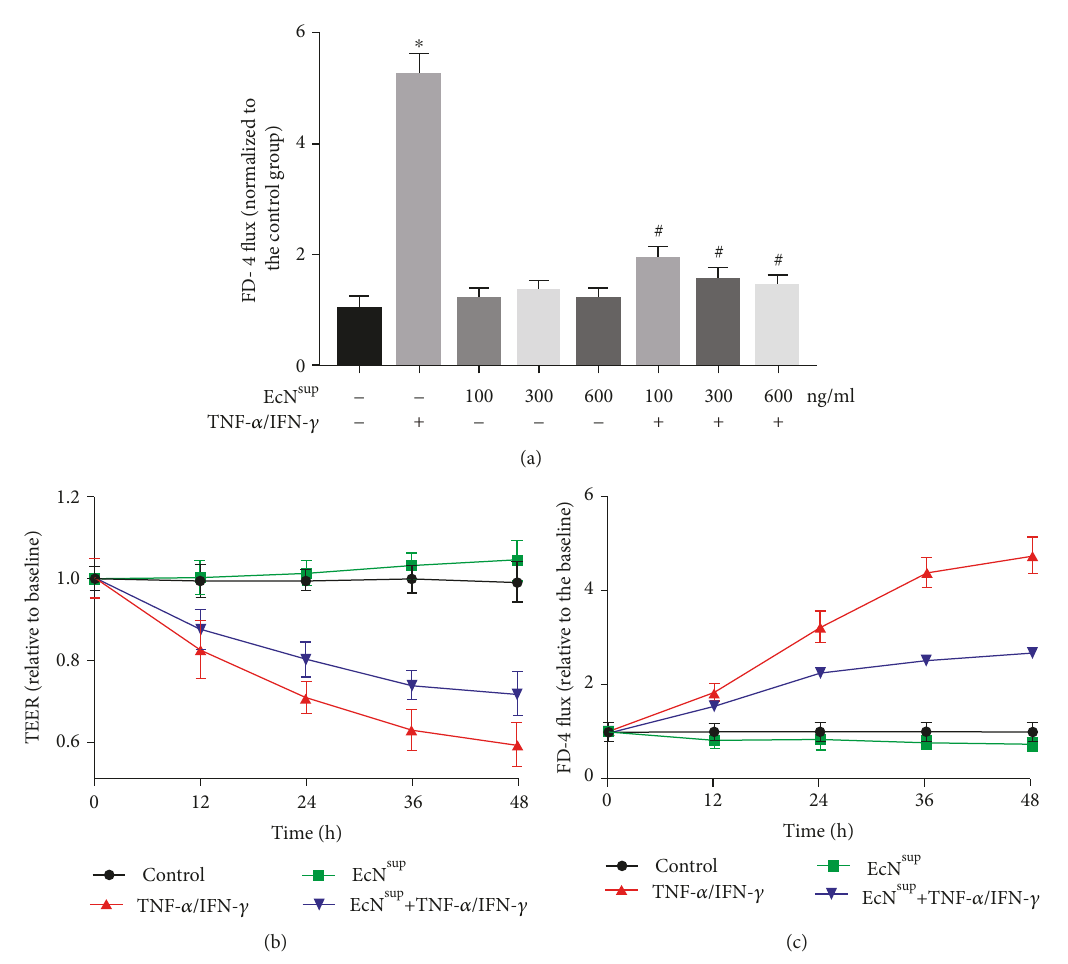
Figure 2: EcN sup attenuated the injury of intestinal barrier function induced by TNF- α /IFN- γ . (a) Caco-2 monolayers were incubated with or without 10ng/mL TNF- α and 10 ng/mL IFN- γ in the presence or absence of 100, 300, and 600 ng/mL EcN sup for 48 h. EcN sup signi fi cantly attenuated the increase of FD-4 fl ux induced by TNF- α /IFN- γ treatment. (b) Caco-2 monolayers were incubated with or without 10ng/mL TNF- α and 10 ng/mL IFN- γ in the presence or absence of 100 ng/mL EcN sup for 48h. EcN sup signi fi cantly attenuated TEER reduction induced by TNF- α /IFN- γ treatment since 12 h. (c) Caco-2 monolayers were treated as described in (b). EcN sup signi fi cantly attenuated the increase of FD-4 fl ux induced by TNF- α /IFN- γ treatment since 12 h. Results were expressed as the mean ± SEM ( n = 3 ). ∗ P < 0 05 vs. control. # P < 0 05 vs. TNF- α /IFN- γ